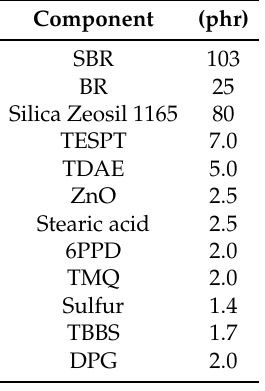
Table 5. Formulation of the silica-based tread compound as used for the analysis of the devulcanizate as shown in the Horikx-Verbruggen diagram in Figure 6.